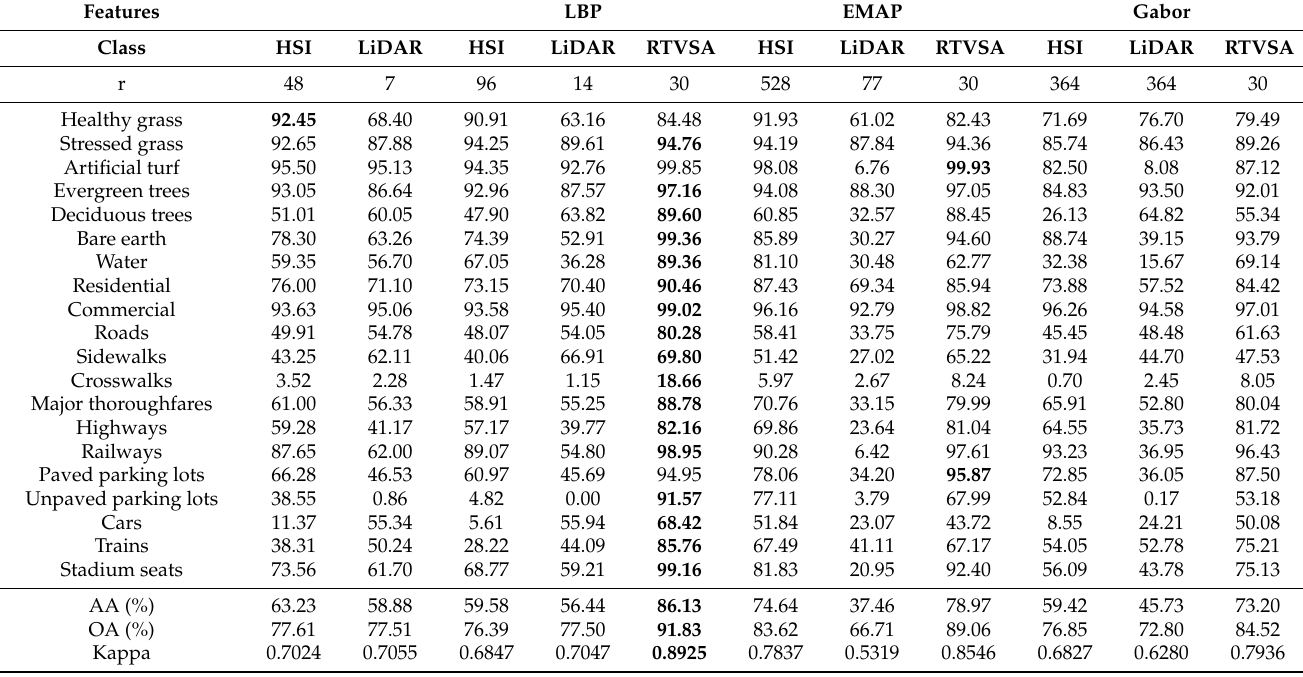
Table 4. The RF classification performance of the proposed method based on the LBP, EMAP, and Gabor feature extraction on the 2017 Houston dataset (%). The best values are shown in